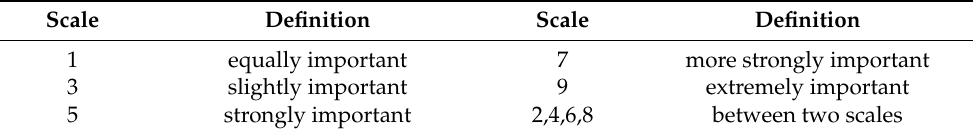
Table 3. The meaning of q ij .